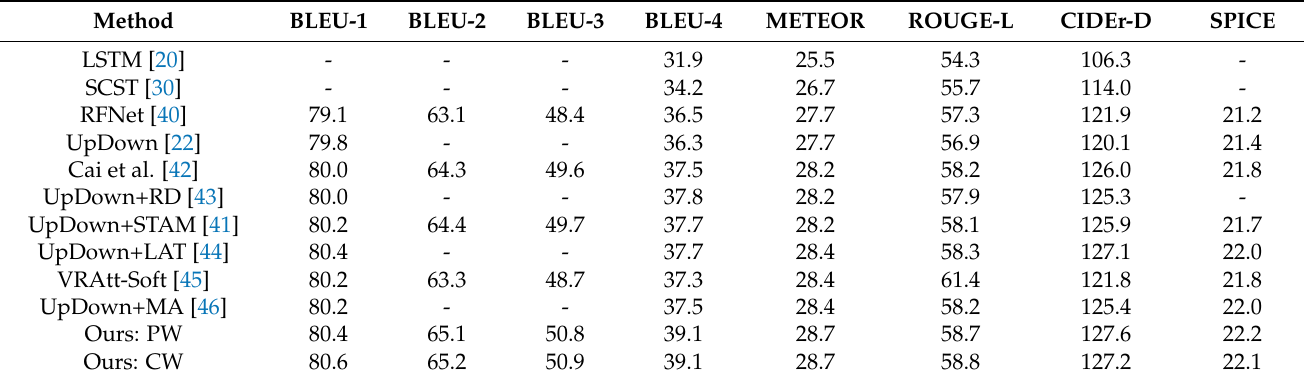
Table 2. The image captioning results of our method and others on the MSCOCO Karpathy test split after CIDEr-D score optimization.